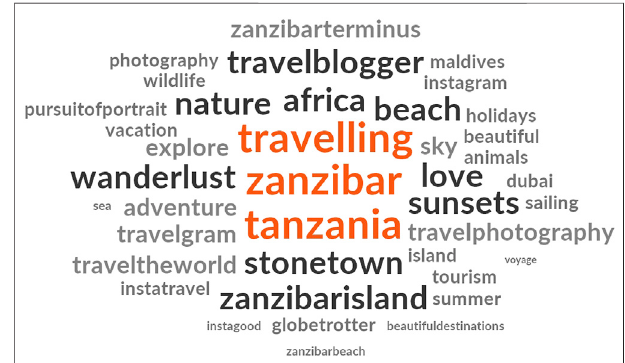
FIGURE 1 | 30 most frequent hashtags ( “ # ” removed). TABLE 5 | Sub-categories of the “ identity ”